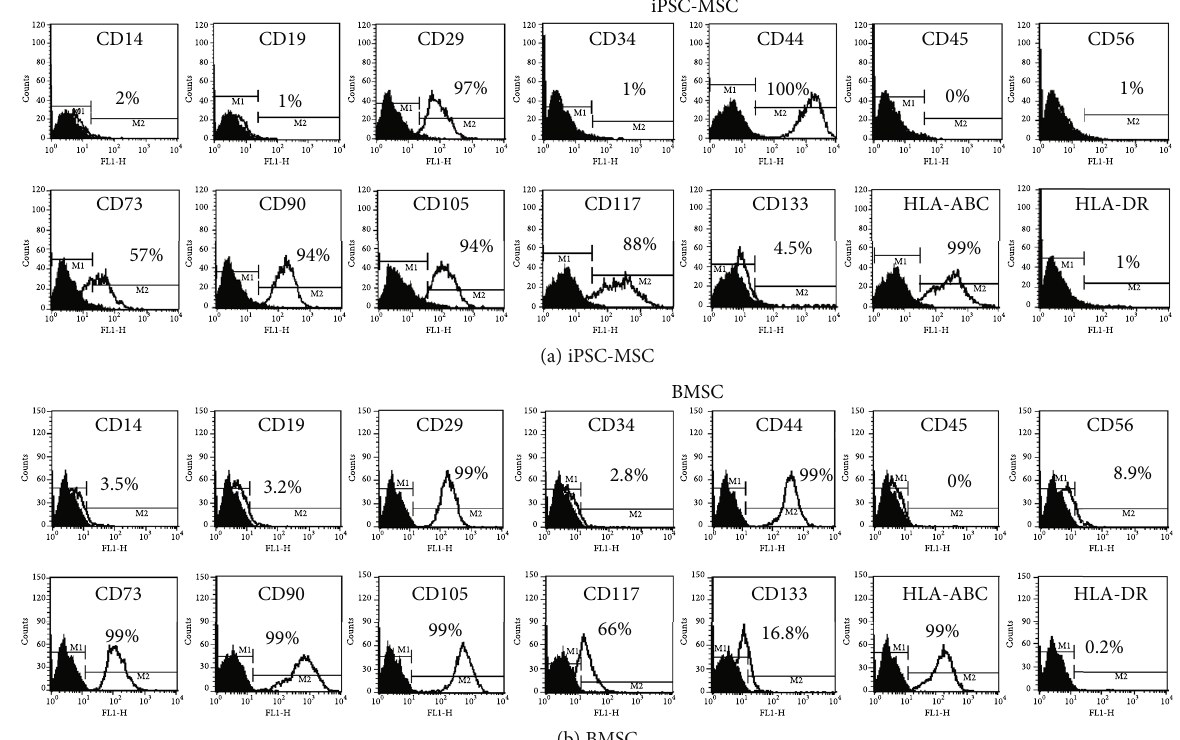
Figure 4: Flow cytometry of iPSC-MSC and bone marrow stem cells (BMSC). (a) Surface marker expression of iPSC-derived MSCs. They have positive expressions of CD29, CD44, CD73, CD90, CD105, CD117, and HLA-ABC and negative for CD14, CD19, CD34, CD45, CD56, CD133, and HLA-DR. (b) Surface markers expression of BMSC. The expression patterns were similar to